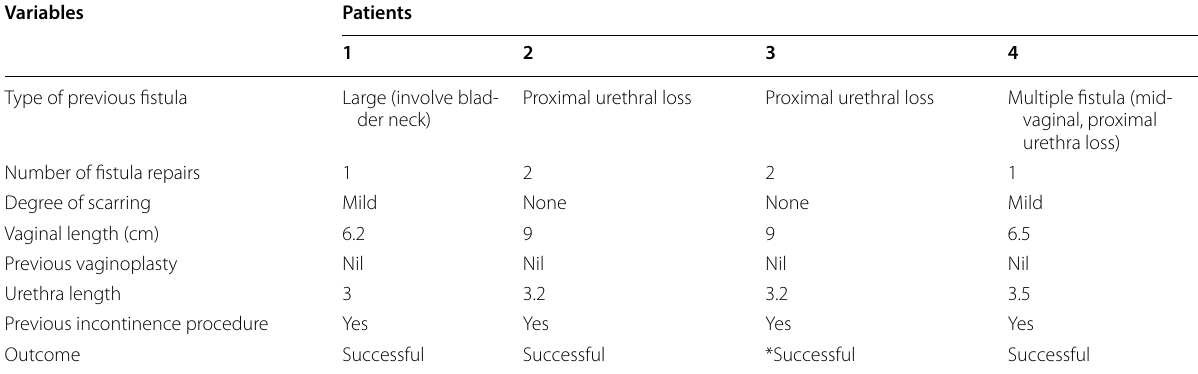
Table 3 Clinical and fistula